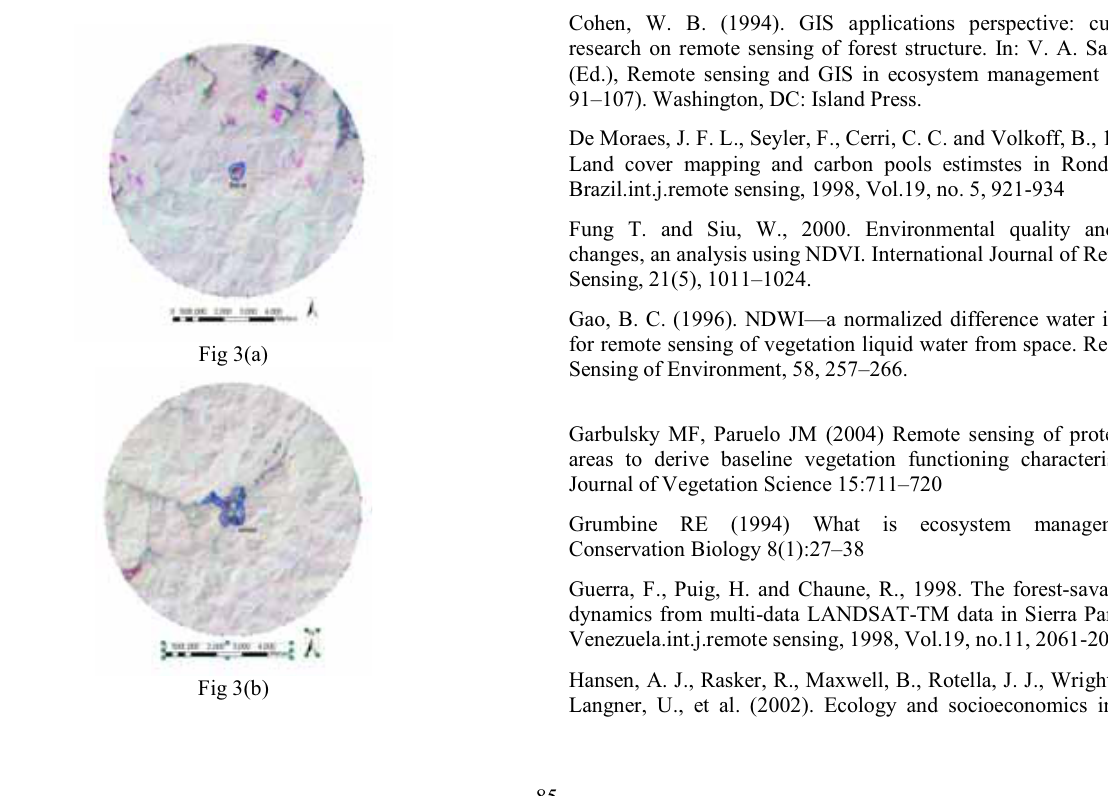
Fig.2 Change in mean NDVI over the